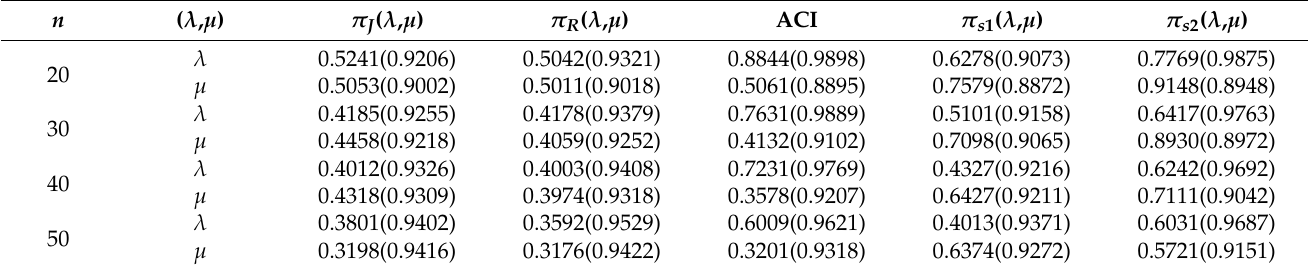
Table 4. The WCIs and CPs (within bracket) of parameters in case I.